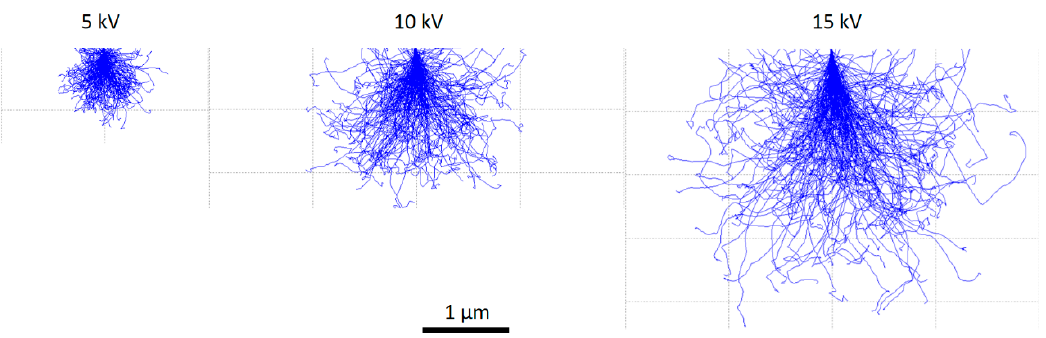
Figure 3. Monte Carlo simulation of the penetration of 200 electrons accelerated at 5, 10, and 15 kV into the slag rim.